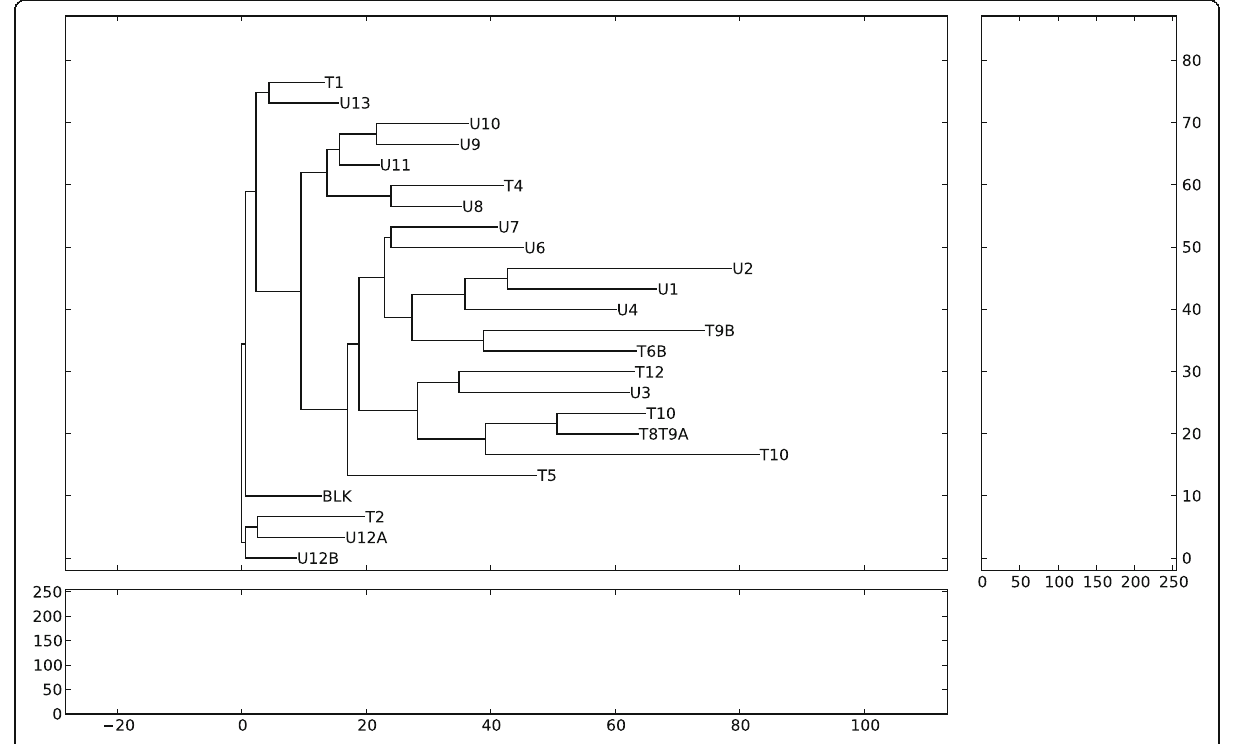
Fig. 4 Phylogenetic tree constructed by PyElph Software Version 1.4 through neighbor end-joining